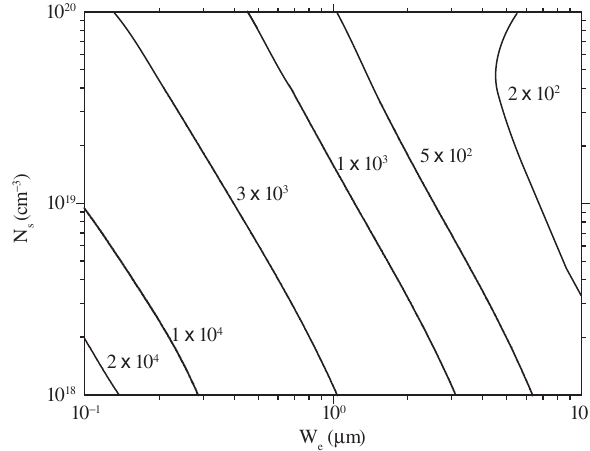
Figure 1. Optimum shadowing factors, F S (mm) as functions of surface doped concentration, N homogeneous emitters.